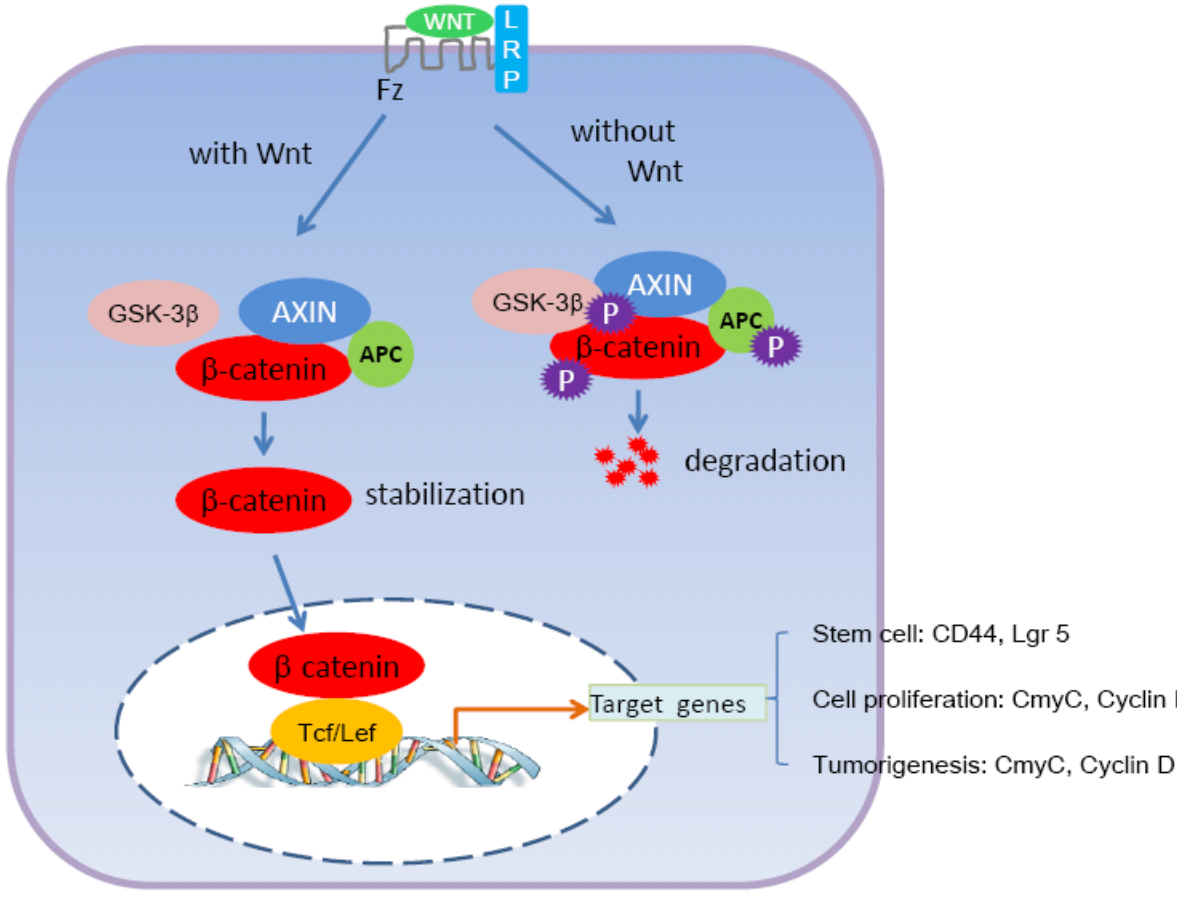
Figure 2. Wnt pathway and its regulation of  -catenin in stem cells and cancer. With Wnt:  -catenin is stabilized and translocated to the nucleus. Nuclear  -catenin binds Tcf, thereby activating Wnt target genes, which in turn regulate stem cells and tumorigenesis. Without Wnt:  -catenin is constitutively